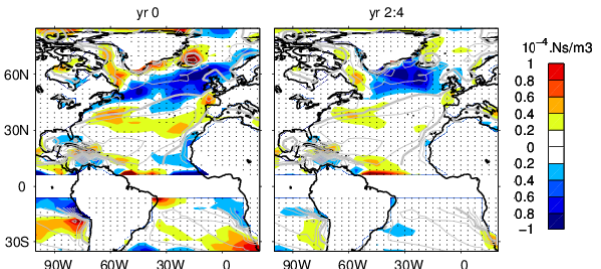
Fig. 9. Composites of anomalous wind stress curl, shown over oceans only, in phase with the volcanic eruption (left) and follow- ing the volcanic eruption by two to four years (right) for the period after 1400 A.D. Grey contours show the annual mean values (con- tour interval is 10 − 4 N sm − 3 ), the thick grey line shows the zero